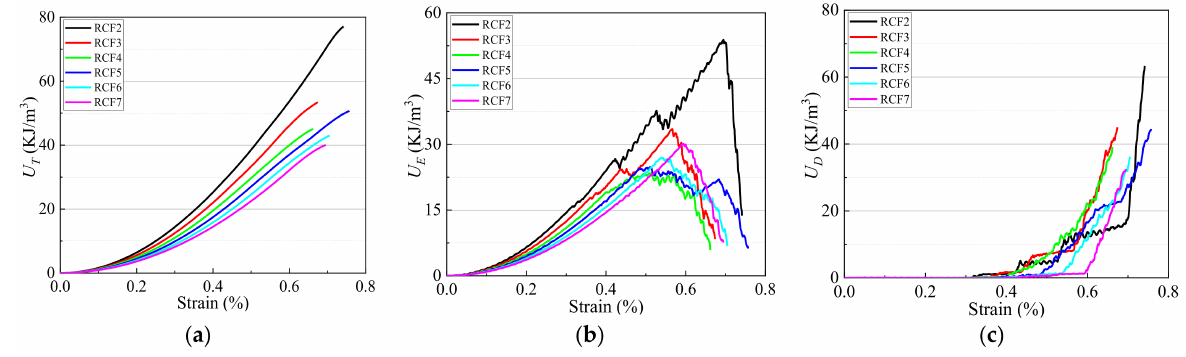
Figure 11. Different types energy evolution of RCF samples: ( a ) U T ; ( b ) U E ; ( c ) U D .